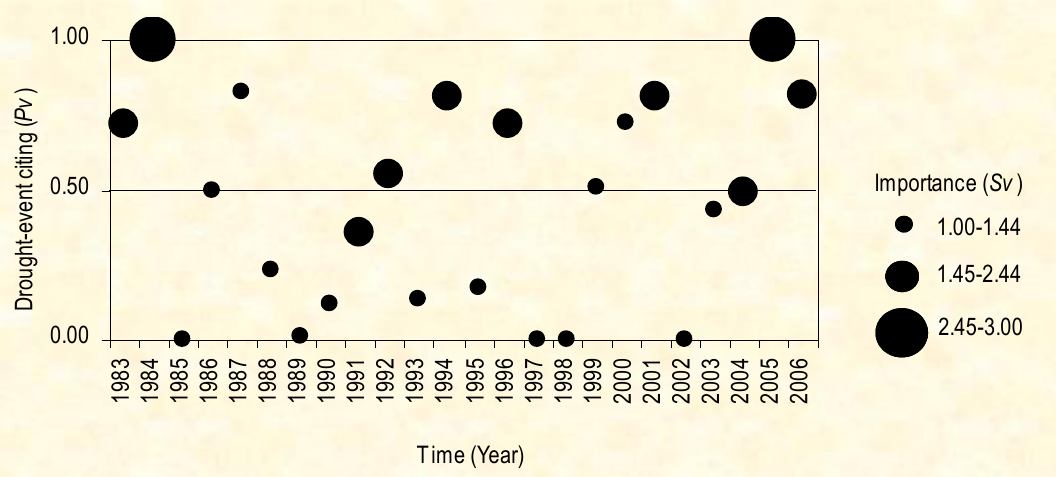
Figure 4. Annual trend of drought occurrence in Kajiado based on emic survey data. Dotted line denotes the border between frequent and infrequent mentioning. Scaled-Importance-value ( Sv ): 1 = minor, 3 = extreme. Contrast: temporal = spatial = p < 0.01.